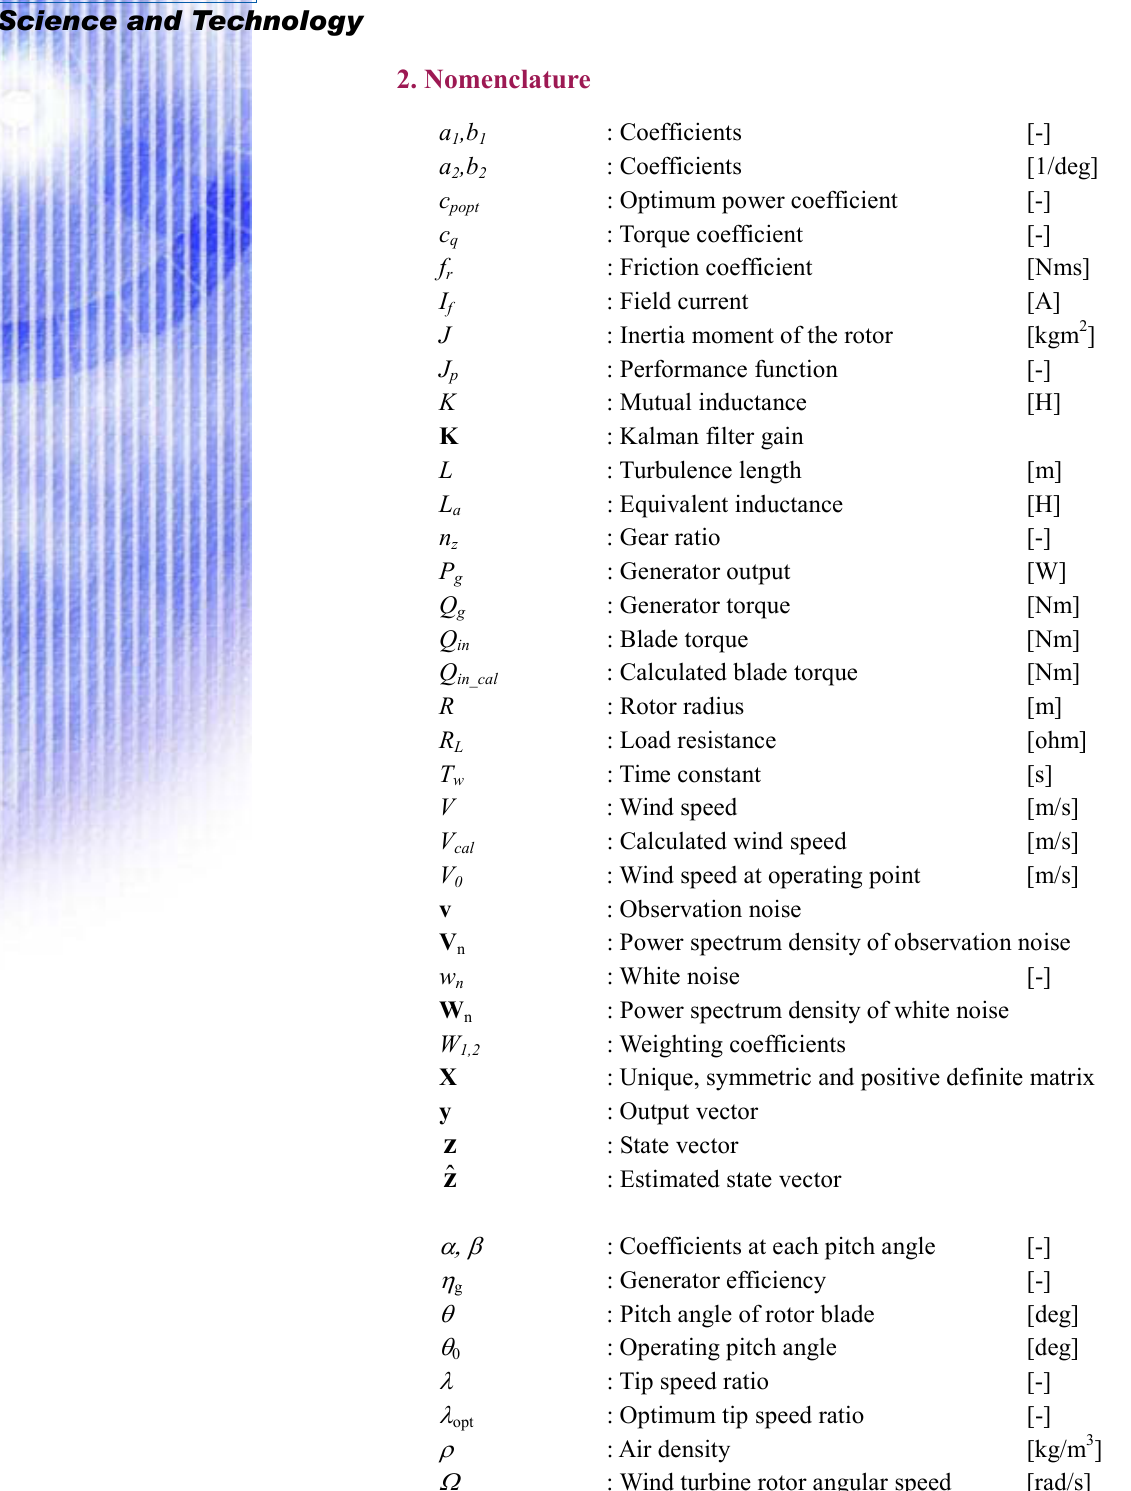
Figure 1 and Table 1 show the outline and specifications of the prototype WTG. The prototype is a 4 m diameter, horizontal, upwind wind turbine with a power rating of 3 kW, with a free yaw and three variable pitch blades. The blades are designed with thin airfoil and a tip speed ratio of 3, which is a half value of conventional design. The performance of the WTG was analyzed using the blade element momentum theory. Figure 2 shows the relationship between each torque coefficient c and tip speed ratio λ with blade pitch q